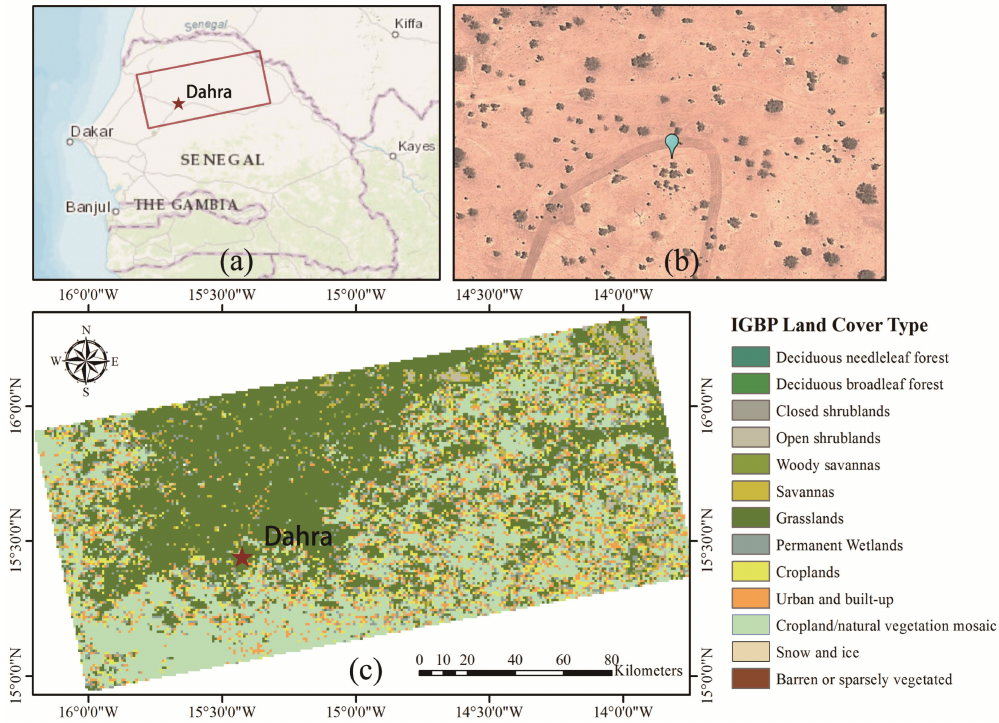
Figure 1. Information of the study area: ( a ) map of Senegal; ( b ) Google Earth image of the Dahra study site; and ( c ) International Geosphere Biosphere Programme (IGBP) land-cover types of the study